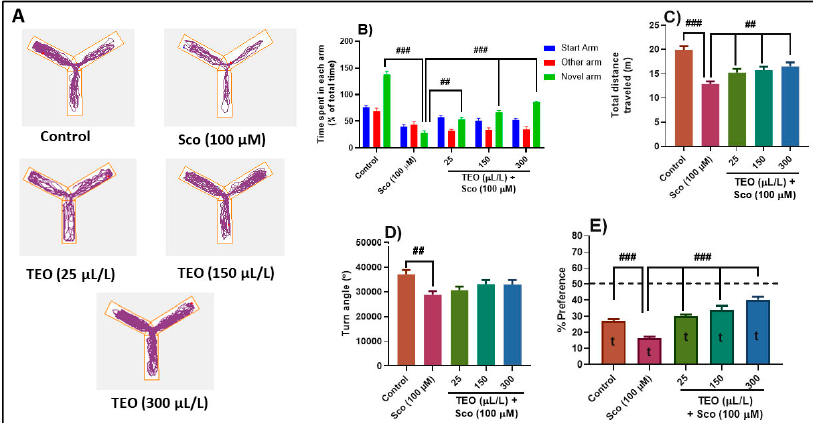
Figure 3. Thymus vulgaris essential oil (TEO: 25, 150, and 300 µL/L) improved locomotion pattern and memory in the Y-maze test. ( A ) Representative locomotion tracking pattern of the control, scopolamine (Sco: 100 µM), and TEO (25, 150, and 300 µL/L) treated groups. ( B ) Represent time spent in each arm (start, novel and novel arm) in different groups. ( C ) Represent the total distance traveled by zebrafish in the tank in different groups. ( D ) Represent the turn angle of zebrafish in the tank in different groups. Values are means ± S.E.M. ( n = 10). For Tukey’s post hoc analyses: ( B ) Control vs. Sco (100 µM): ### p < 0.0001, Sco vs. TEO (25 µL/L): ## p < 0.001, Sco vs. TEO (150 µL/L): ### p < 0.0001 and Sco vs. TEO (300 µL/L): ### p < 0.0001; ( C ) Control vs. Sco (100 µM): ### p < 0.0001, Sco vs. TEO (25 µL/L): ## p < 0.001, Sco vs. TEO (150 µL/L): ## p < 0.001 and Sco vs. TEO (300 µL/L): ## p < 0.001; ( D ) Control vs. Sco (100 µM): ## p < 0.001; ( E ) Control vs. Sco (100 µM): ### p < 0.0001, Sco vs. TEO (25 µL/L): ### p < 0.0001, Sco vs. TEO (150 µL/L): ### p < 0.0001 and Sco vs. TEO (300 µL/L): ### p < 0.0001.